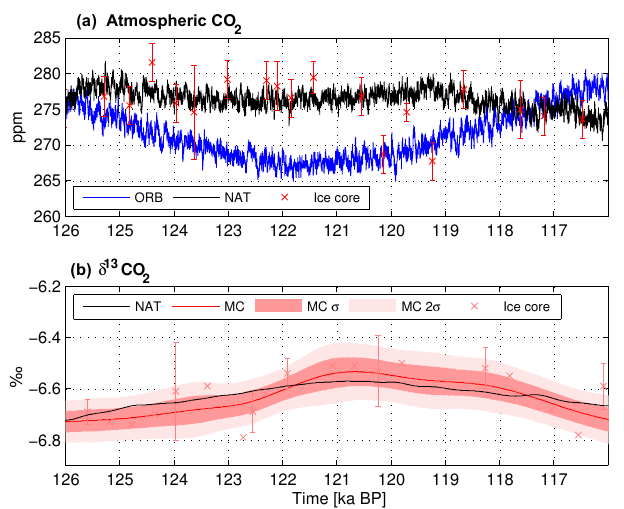
Figure 6. Eemian CO 2 concentration (a) and δ 13 of CO 2 (b) from model experiments and ice core data. δ 13 CO 2 model results have been smoothed for clarity and offset, as described in the text. Ice core CO 2 data are from EDC as compiled by Bereiter et al. (2015). δ 13 CO 2 data are from EDC (Schneider et al., 2013), with Monte Carlo average (MC) and uncertainty estimate (MC σ